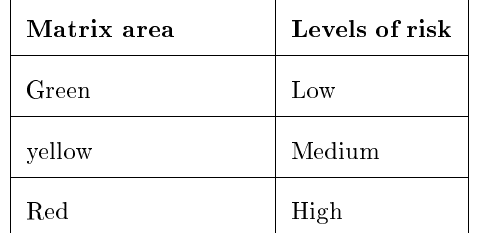
Tab. 7: lazakis [7] risk matrix.